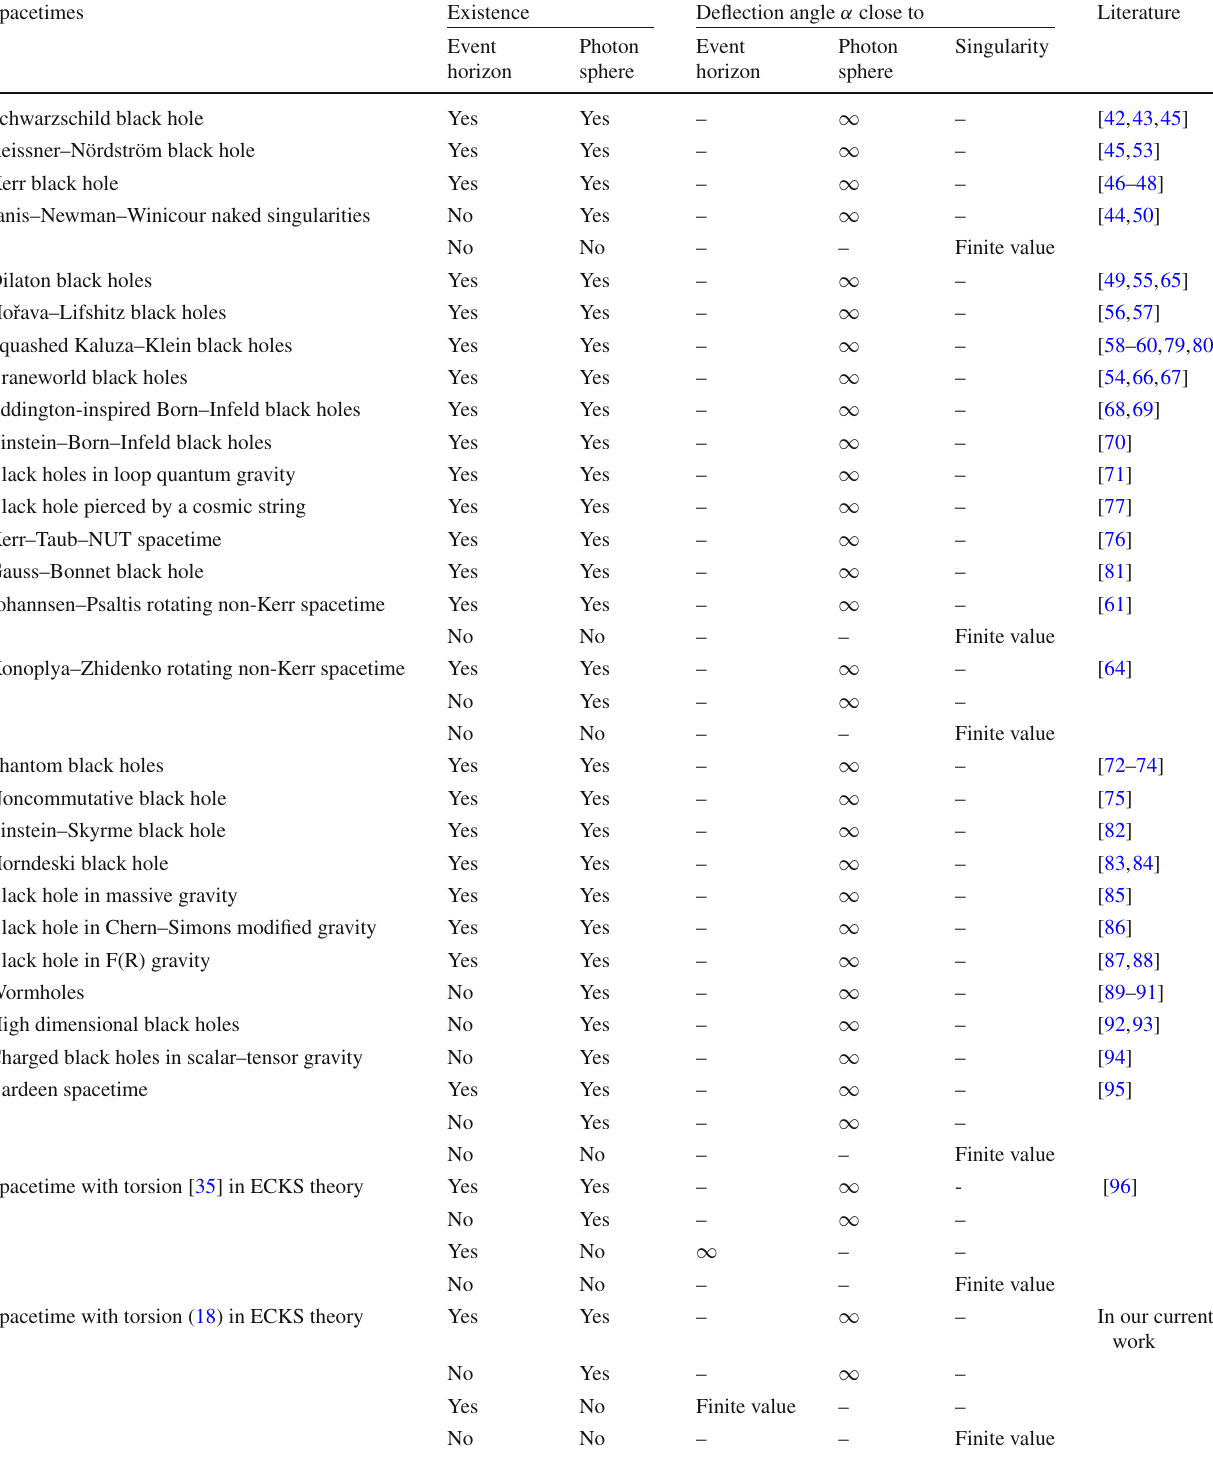
Table 1 Comparison among the main features of gravitational lensing by compact objects in different gravitational theories Spacetimes Existence Deflection angle α close to Literature